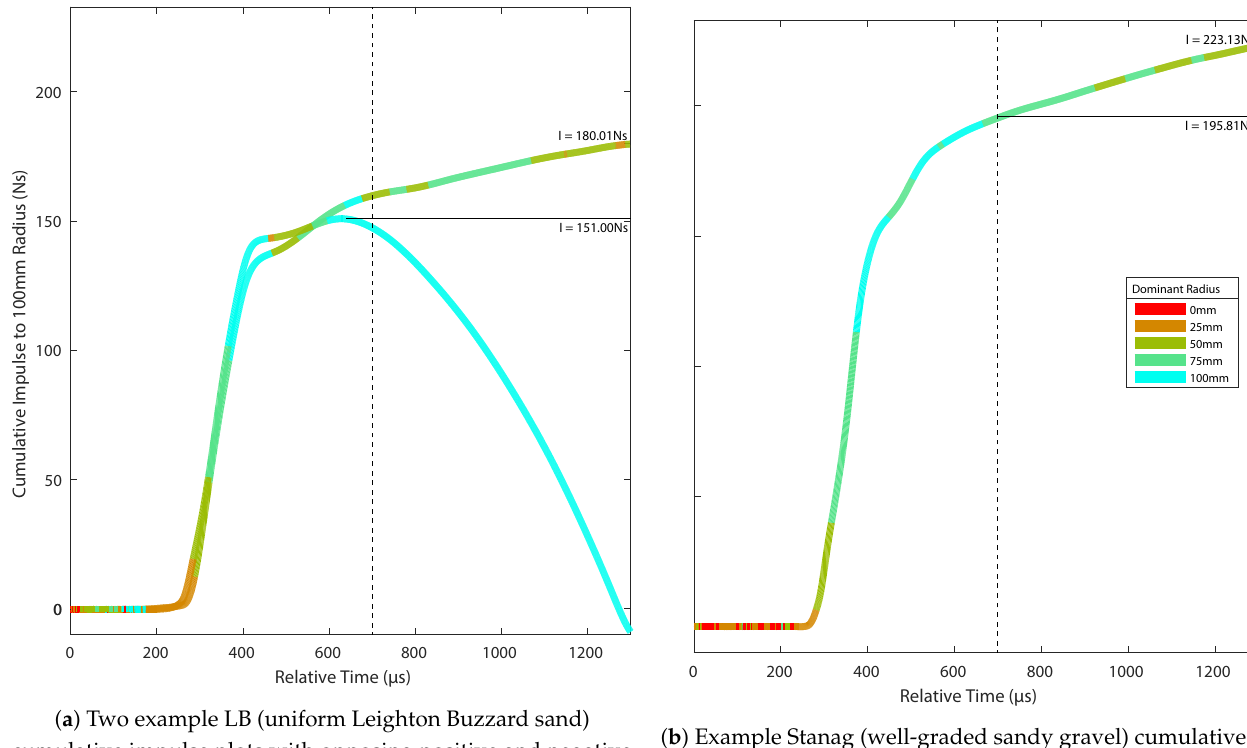
( a ) Two example LB (uniform Leighton Buzzard sand) ( b ) Example Stanag (well-graded sandy gravel) cumulative cumulative impulse plots with opposing positive and negative impulse plot with positive signal drift. signal drift. Figure 5. 1.3 ms truncated signals with opposing drift directions, dashed line shows reduced 0.7 ms truncation period. ‘Dominant radius’ indicates where the majority of impulse contributions are occurring at that